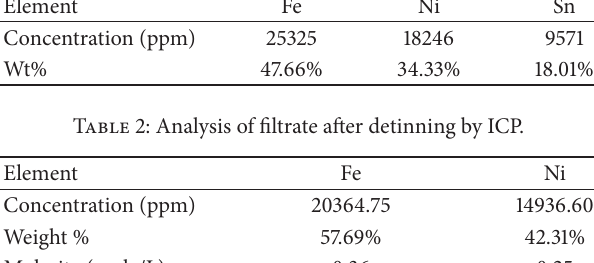
Figure 1: SEM diagram of Ni-Zn ferrite/TiO 2 ( ×